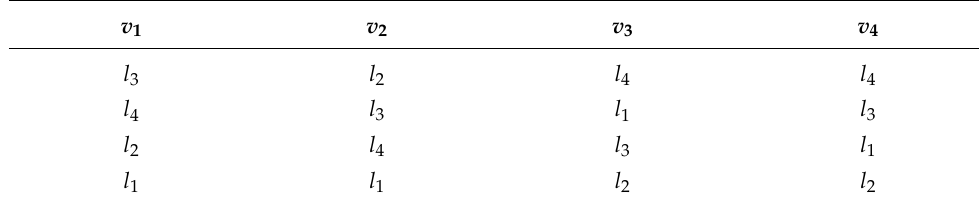
Table 2. VSP preferences over LiDAR sensors.